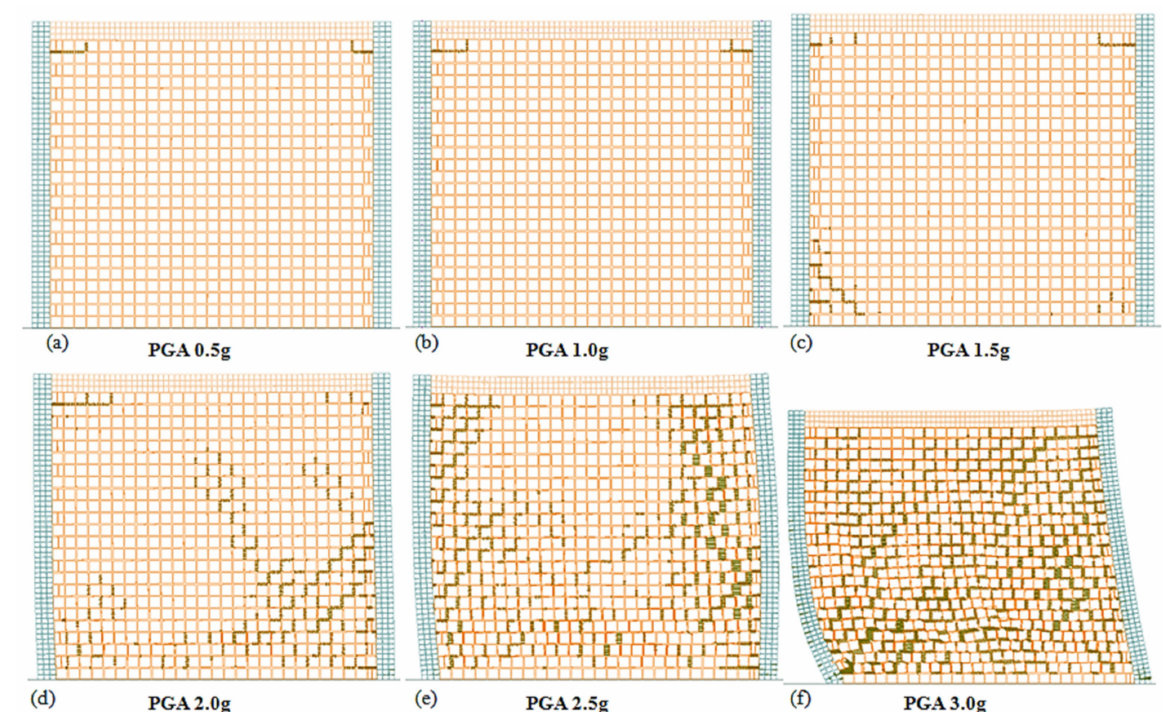
Figure 24. Damage profiles of AEM models for IFM wall structure at PGA: ( a ) 0.5 g; ( b ) 1.0 g; ( c ) 1.5 g;